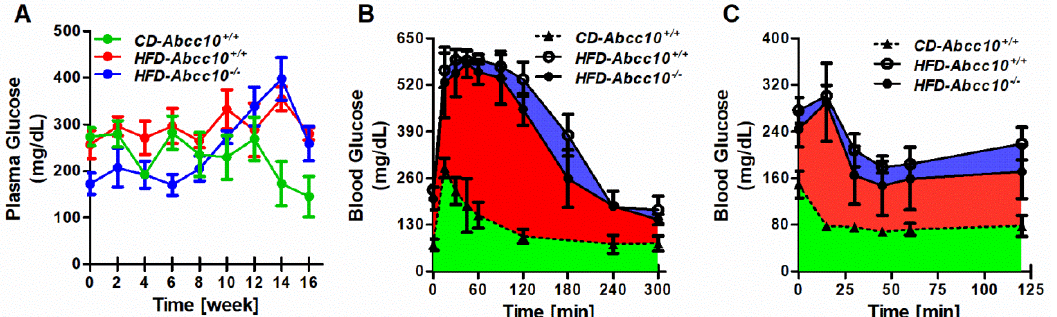
Figure 4. Deficiency of ABCC10 does not affect blood glucose, glucose tolerance, and insulin tol- erance in high-fat-diet-fed mice. Eight-week-old Abcc10 +/+ ( HFD-Abcc10 +/+ , n = 4) and Abcc10 − / − ( HFD-Abcc10 − / − , n = 5) male mice were fed high-fat obesity diet for 16 weeks. As a control, age-matched Abcc10 +/+ ( CD-Abcc10 +/+ , n = 4) male mice were kept on chow diet during this period. Blood was collected every two weeks in the overnight-fasted mice through tail vein bleeding, and plasma glucose was measured ( A ). After 14 weeks of feeding, GTT ( B ) and ITT ( C ) were performed in these mice and the area under the curve was plotted. Values are plotted as replicates (mean ± SD).